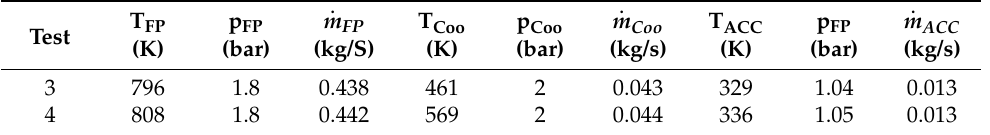
Table 8. Settings for the numerical simulations: temperatures, pressure and mass flow rates for the Flow Path, Cooling and Active Clearance